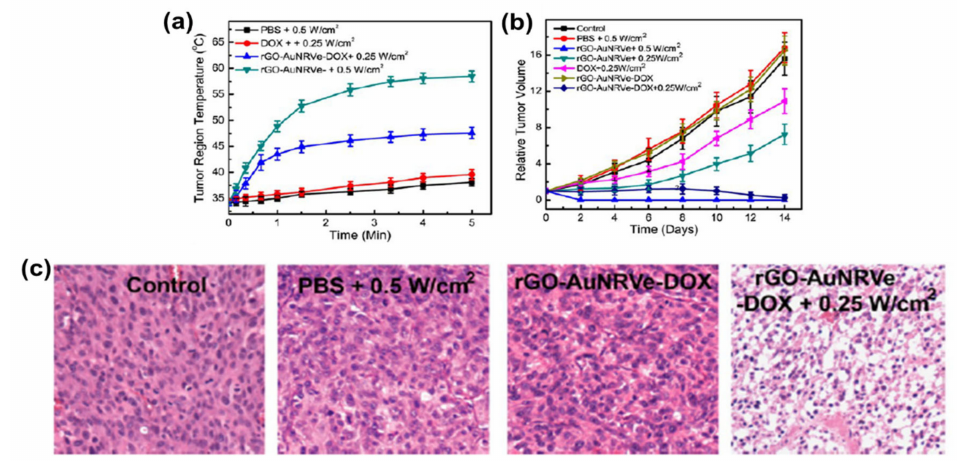
Figure 10. ( a ) Tumor region temperature changes of the mice treated with PBS, DOX, and rGO–AuNRsVe–DOX irradiated with an 808 nm laser of di ff erent power densities for 5 min. ( b ) Relative tumor volume of the tumor-bearing mice after intravenous injection of the samples and exposed to the 808 nm laser at di ff erent power densities. Tumor volumes were normalized to their initial sizes. ( c ) Images of H&E (hematoxylin and eosin)-stained tumor sections harvested from the tumor-bearing mice treated with PBS and rGO–AuNRsVe–DOX with or without laser irradiation. Adapted from [34] with permission from American Chemical Society, 2015. Ve: vesicle.